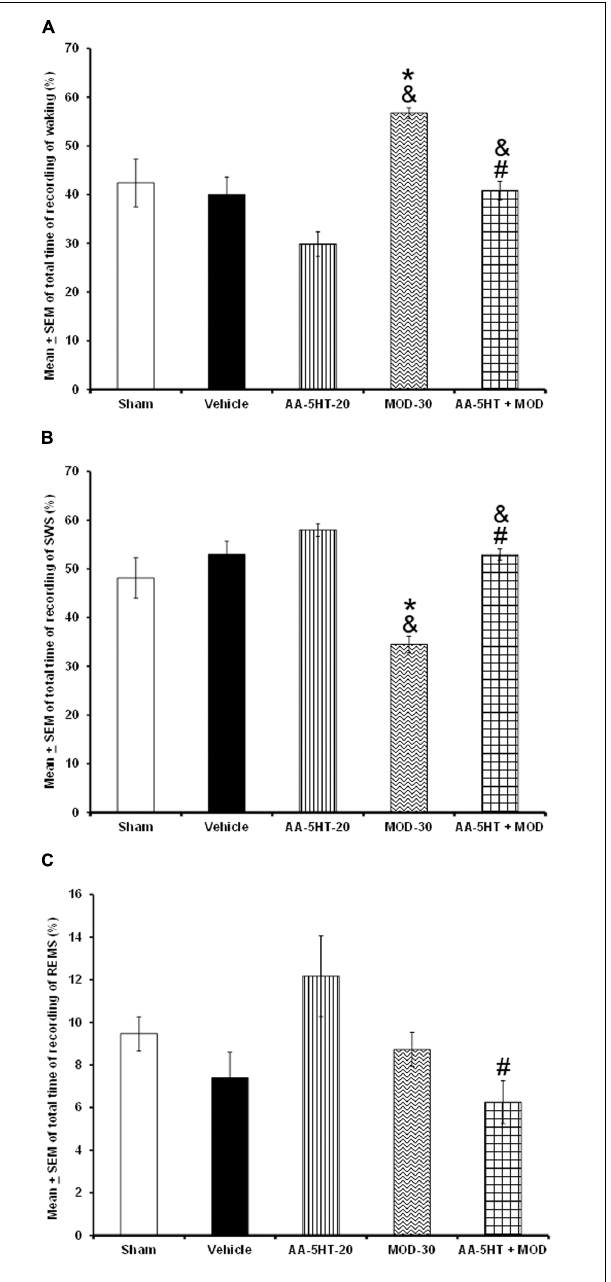
FIGURE 5 | Effects on total time of W, SWS, and REMS after experimental trials: Sham, vehicle, AA-5-HT (20 mg/Kg; i.p.), modafinil (MOD, 30 mg/Kg; i.p.) or AA-5-HT (20 mg/Kg; i.p.) and 15 min MOD (30 mg/Kg; i.p.). AA-5-HT caused no statistical difference in waking, SWS and REMS if injected at the beginning of the lights-on period. However, the administration of MOD (30 mg/Kg; i.p.) increased W and decreased SWS. No statistical changes were observed in REMS in MOD-treated animals. Interestingly, administration of AA-5-HT 15 min before the injection of MOD prevented the enhancement in waking as well as the diminution in SWS. Despite that MOD induced no effects in REMS, combination of AA-5-HT + MOD decreased REMS ( A–C , respectively) induced by the stimulant (Mean ± SEM ∗ vs. Sham/Vehicle, P < 0.05; & vs. AA-5-HT-20, P < 0.05; # vs. MOD-30, P < 0.05). Abbreviations: Modafinil 30 mg/Kg, i.p. (MOD-30), AA-5-HT-20 mg/Kg